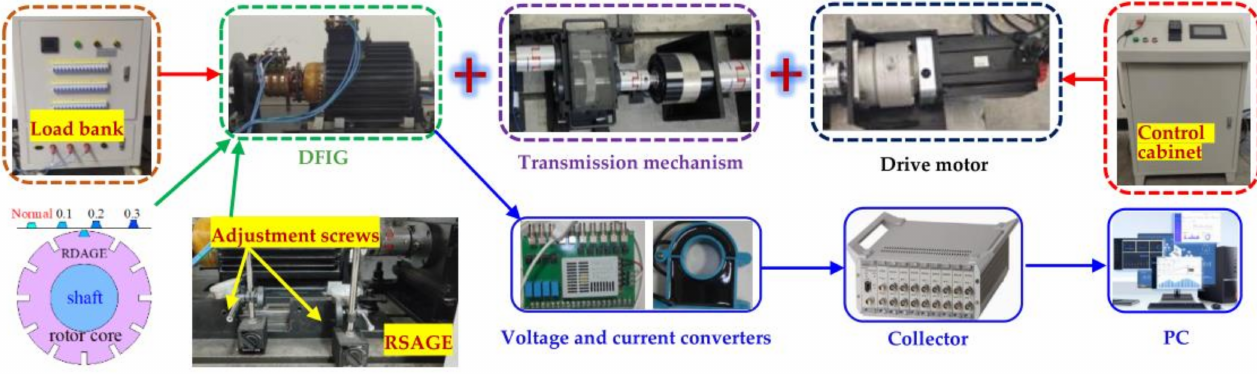
Figure 6. Experimental device of DFIG